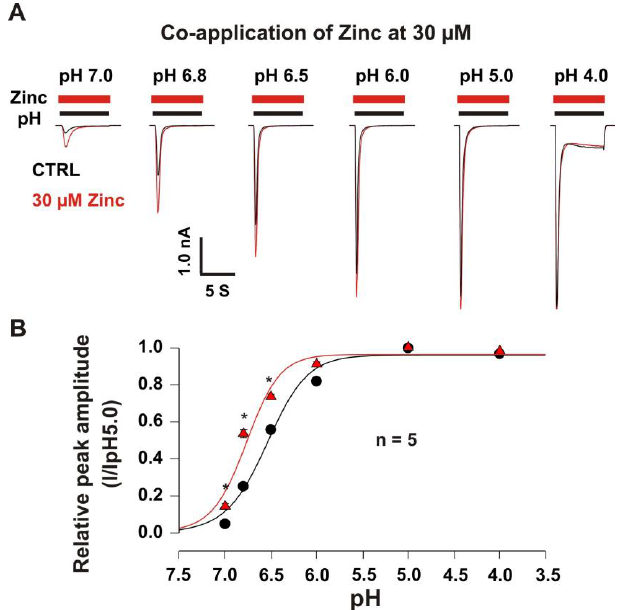
Figure 4. Co-application of zinc at a concentration of 30 µM leftward shifted pH dose–response curve of heteromeric ASIC1a/3 currents. ( A ) Representative traces show that co-application of zinc at a concentration of 30 µM potentiated heteromeric ASIC1a/3 currents with pH dependence; ( B ) Co-application of zinc at a concentration of 30 µM shows a leftward shift of the pH 50 from 6.54 ± 0.05 without co-application of zinc to 6.77 ± 0.05 with co-application of zinc at a concentration of 30 µM ( p < 0.05, n = 5). Whole-cell patch-clamp recording was performed. Relative peak amplitude with or without zinc treatment was measured by ASIC current (I) on a drop in pH from 7.4 to 7.0, 6.8, 6.5, 6.0, 5.0, or 4.0 divided by ASIC current (I pH5.0 ) on a drop in pH from 7.4 to 5.0. Data are presented as mean ± SEM. CTRL, control. * p < 0.05.